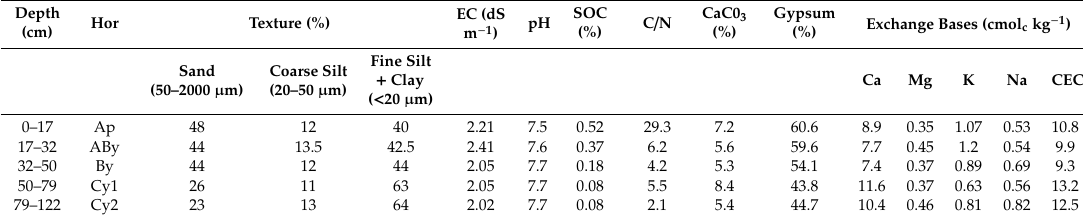
Table 1. Main soil characteristics from a pit excavated in 2017. EC: electrical conductivity; Hor: genetic horizon; CEC: cation exchange